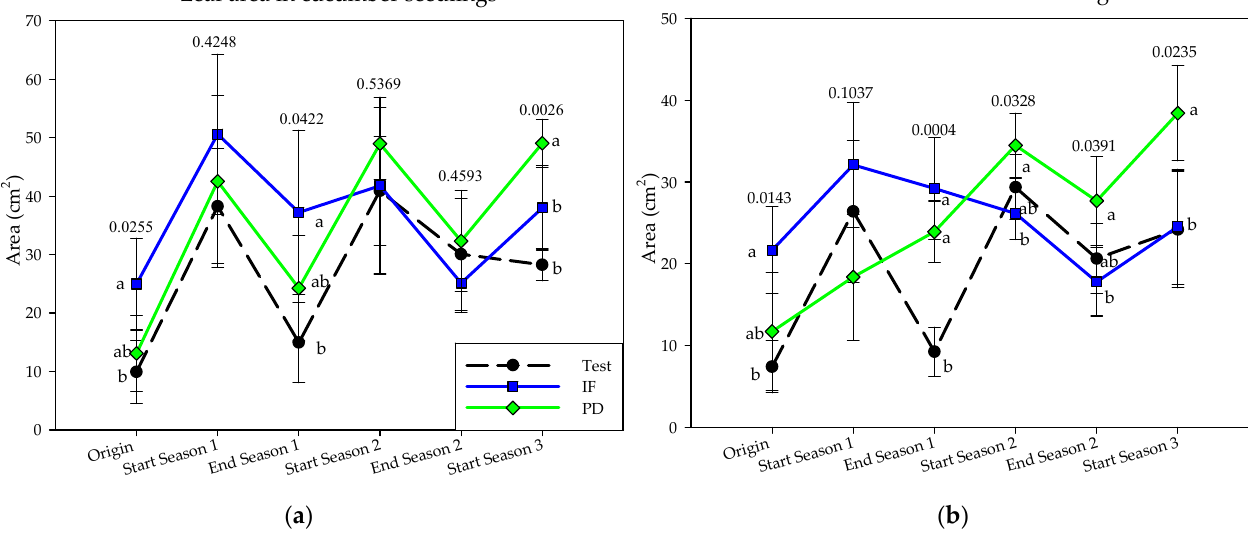
Figure 7. Leaf area of seedlings grown in controlled chamber conditions in the three years of study (September–April cycles) as a function of crop nutrition: ( a ): cucumber; ( b ): tomato. Inorganic fertilization (IF; n = 4); tomato plant debris (PD; n = 4); no fertilization (Test; n = 4). Values (mean ± standard deviation). Different letters in the evolution lines indicate significant differences ( p ≤ 0.05, Tukey’s HDS test).